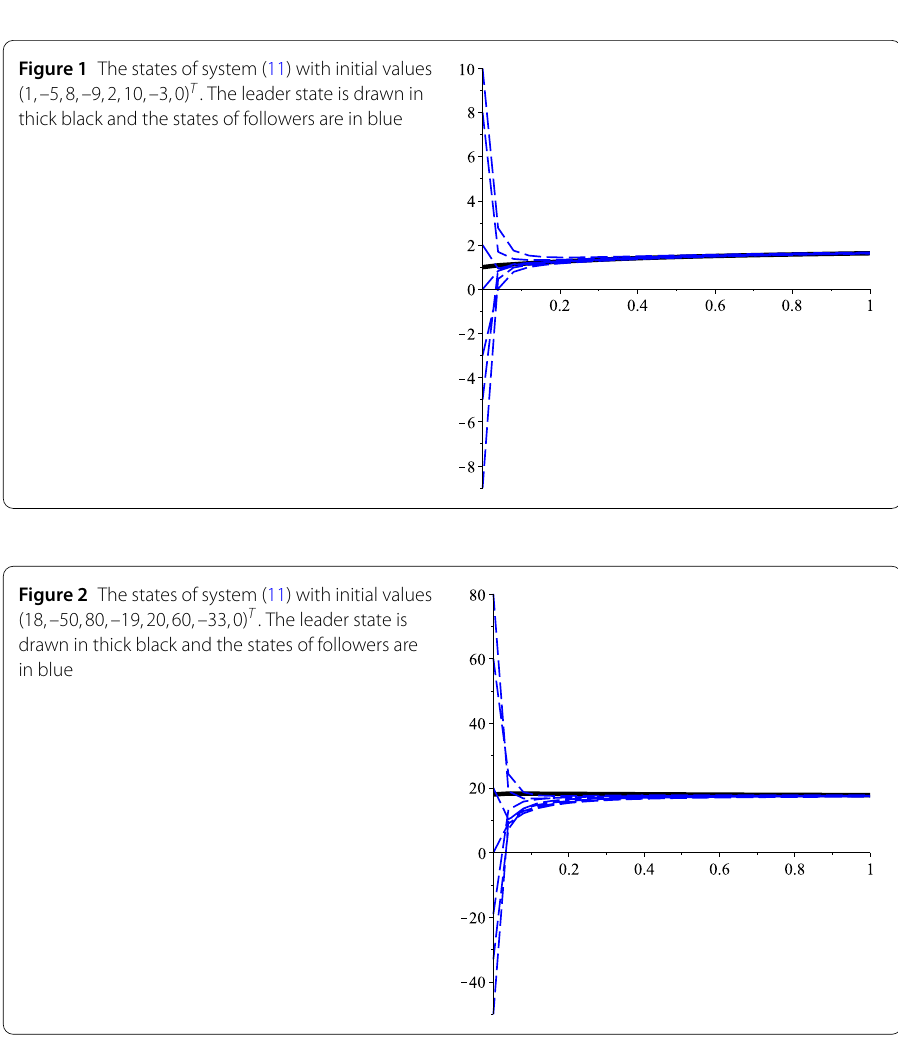
The eigenvalues of the matrix H = L + B are 0.07, 0.382, 0.6767, 1.4080,